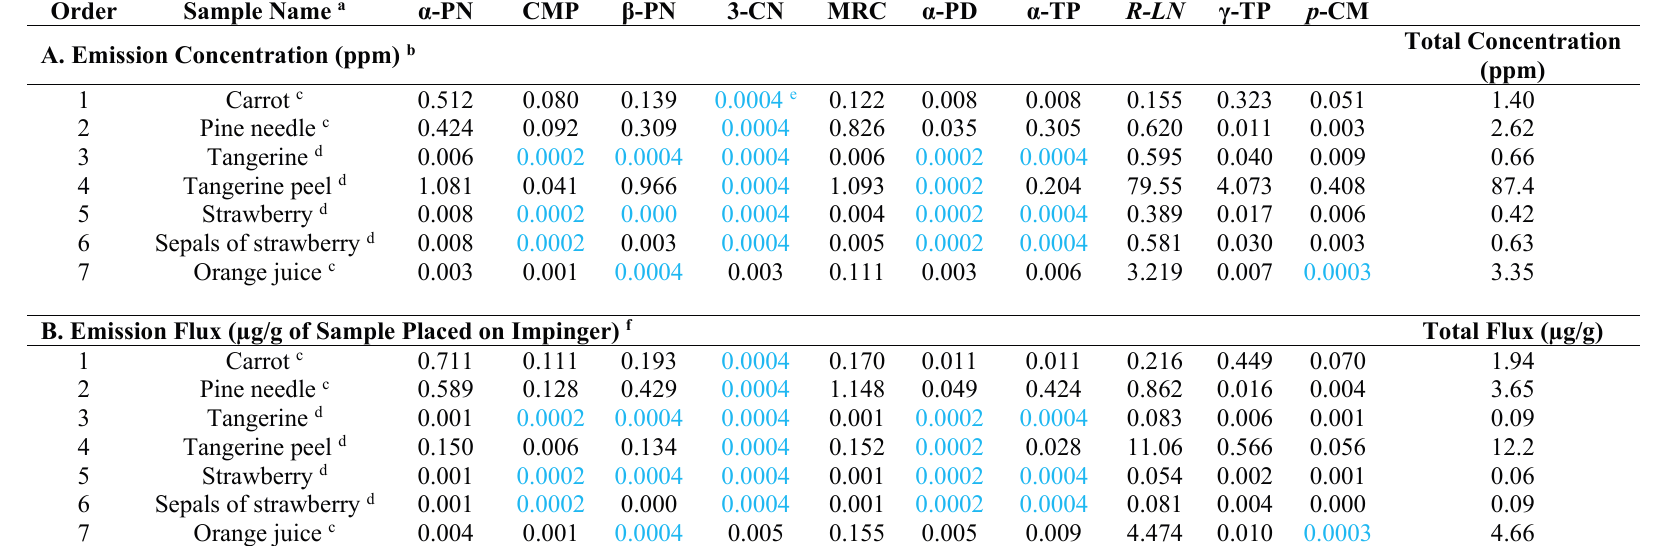
Table 2. Result of MT emission measurements based on headspace analysis of fruit/plant/vegetable samples using ST/TD/GC/MS